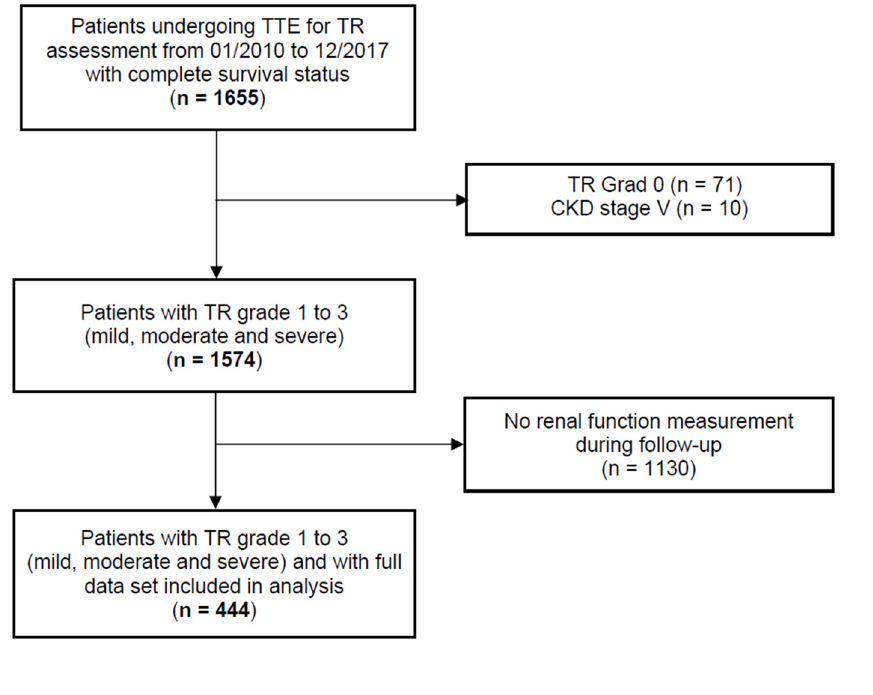
Figure 1. Patient flow through the study.